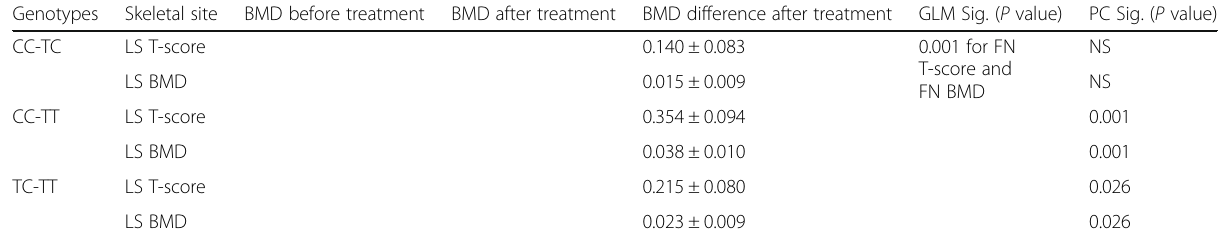
Table 6 BMD changes after hormone therapy in relation to the rs9340799 and rs2234693 genotypes (Continued)